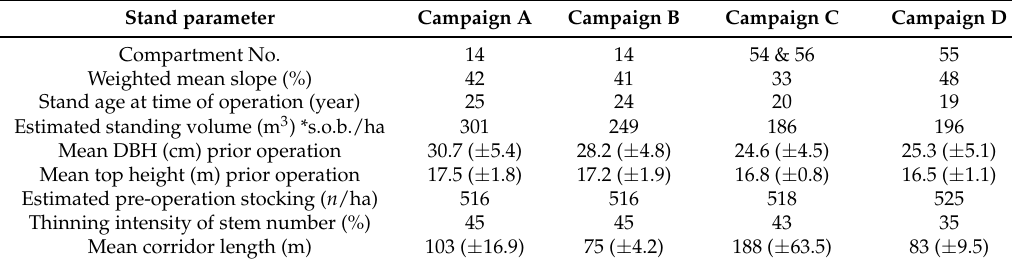
Table 1. Stand Descriptions of Test Sites at Baiyun Forest Farm. Stand Parameters are based on Inventory Data Provided by ECTF, All Stands Consisted of Pine, Stocking on Lateritic Red Soils, Established by Planting at an Initial Spacing of 2 m × 2 m and Stocking of 2500 Trees/Ha. All Operations Were 2nd Thinnings With Uphill Yarding Direction. Standard Deviations in Parenthesis. Stand